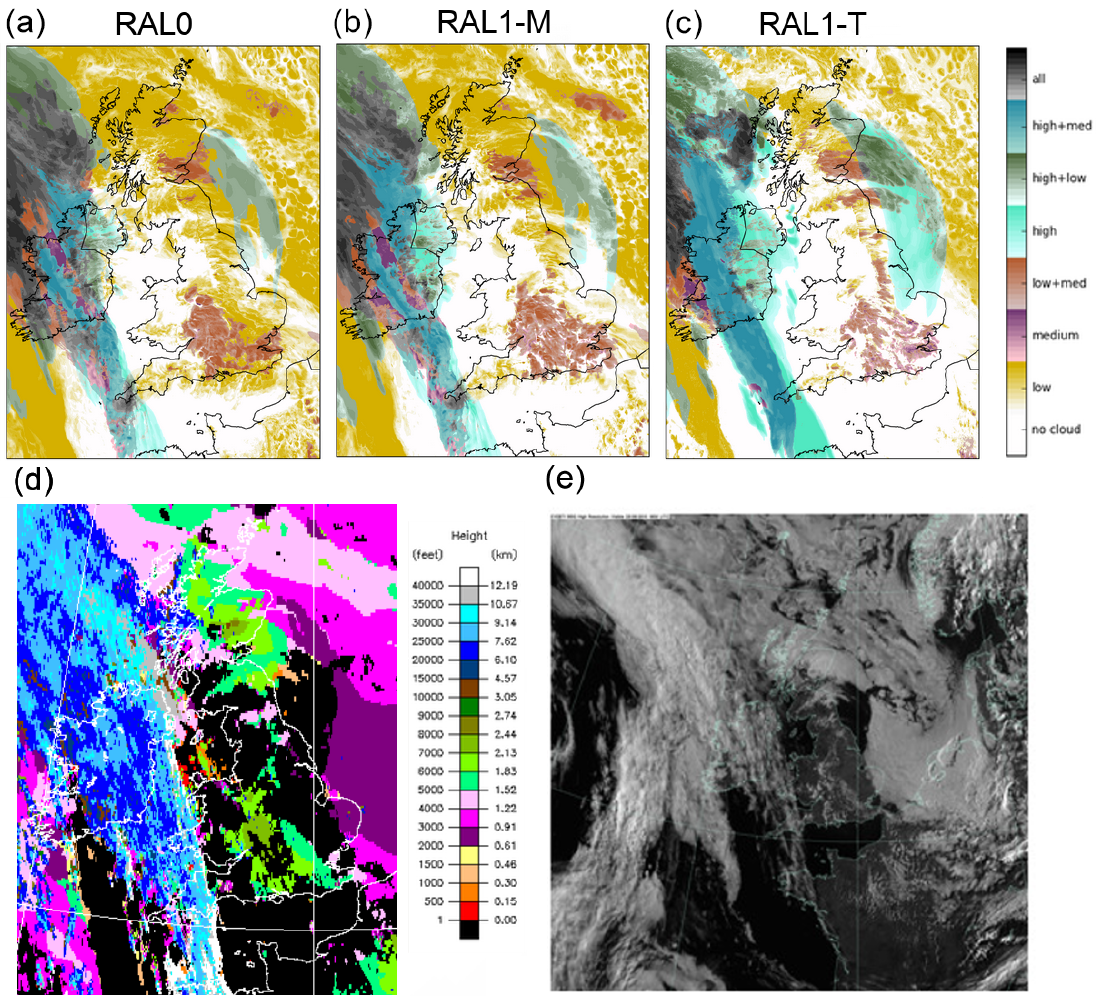
Figure 13. Cloud cover at T + 18 (stratocumulus case) showing RAL0 (a) , RAL1-M (b) and RAL1-T (c) at 18:00Z on 23 June 2015 with corresponding satellite imagery; false colour and visible in panels (d) and (e) , respectively. Imagery: © Crown Copyright, Met Office, Data: